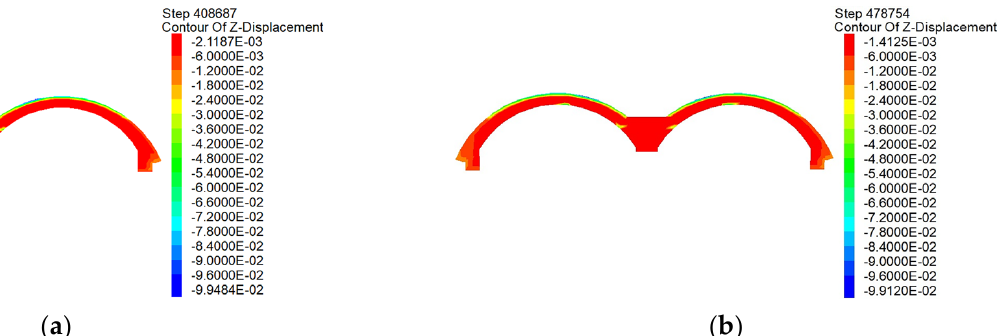
Figure 23. Comparison of the most vertical displacements of the arches completed in ( a ) one and ( b ) two attempts.